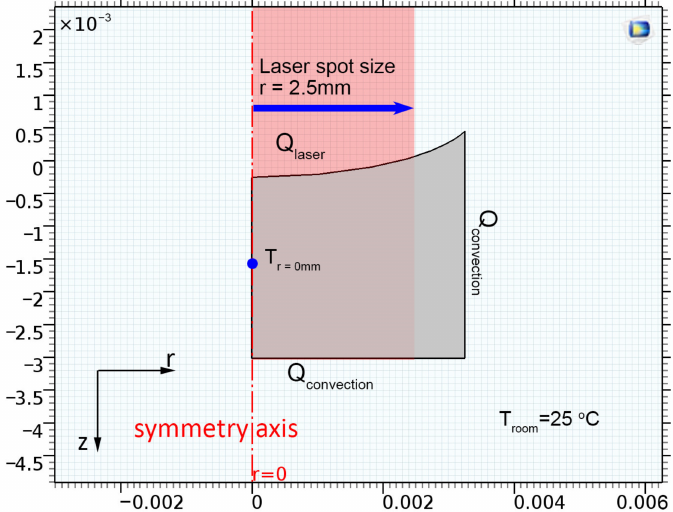
Figure 6. Boundary conditions of the axisymmetric model, where x - and y -axes are the length scales in meters.